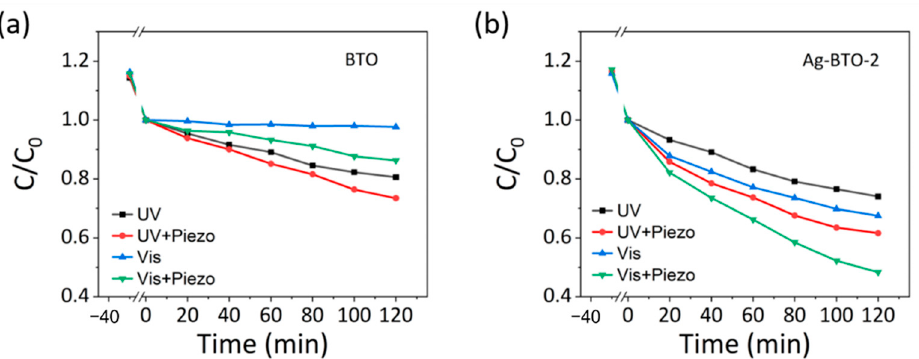
Figure 6. The photocatalysis and piezo-photocatalysis under UV and visible light of ( a ) BTO and ( b ) Ag-BTO-2. ( b )